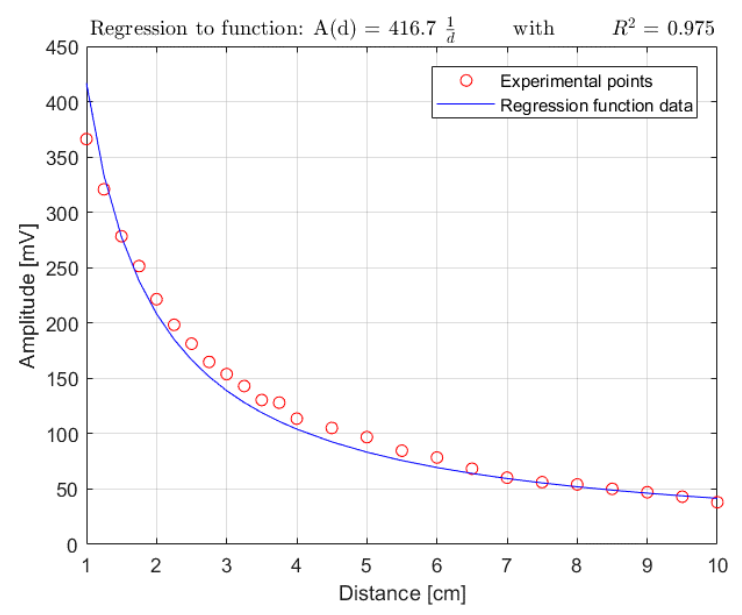
Figure 13. Comparison between experimental points and regression function curve.